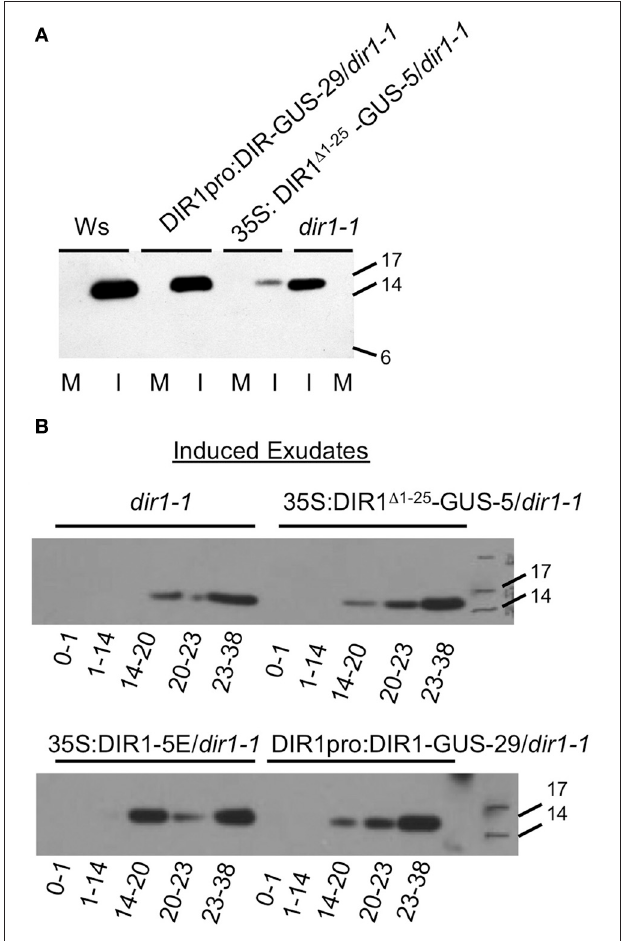
FIGURE 2 | Detection of a DIR1 antibody signal in petiole exudates collected from dir1-1 plants. Petiole exudates were collected from mock-inoculated (M) and SAR-induced (I) (10 6 cfu ml − 1 Pst (avrRpt2 ) leaves of DIR1pro:DIR1-GUS-29/ dir1-1 ,35S: DIR1 (cid:2) 1 − 25 -GUS-5/ dir1-1 , Ws and dir1-1 , then lyophilized and subjected protein gel blot analysis with the DIR1 antibody. (A) Petioles exuded from 8 to 44hpi (B) . SAR-induced leaves were collected at various times following inoculation and allowed to exude for the indicated amount of time (0–1, 1–14, 14–20, 20–23, 23–38hpi). Protein molecular weight markers are indicated (17, 14, 6kDA), rLTP—recombinant LTP made in E. coli ). These experiments were repeated twice with similar